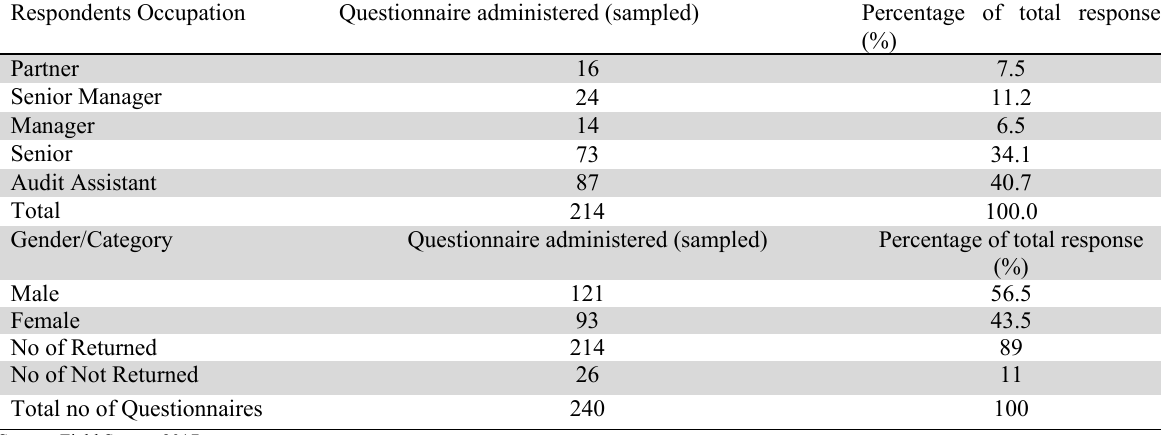
Distribution of respondents and response